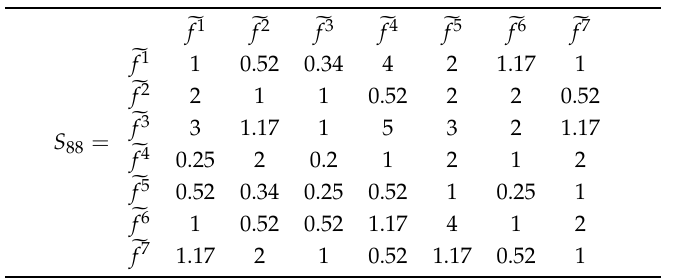
Table 4. Defuzzified comparison matrix.